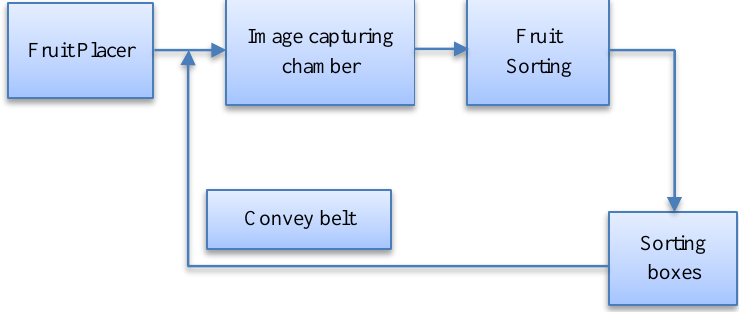
Figure 1. Block diagram of Dates Grading System